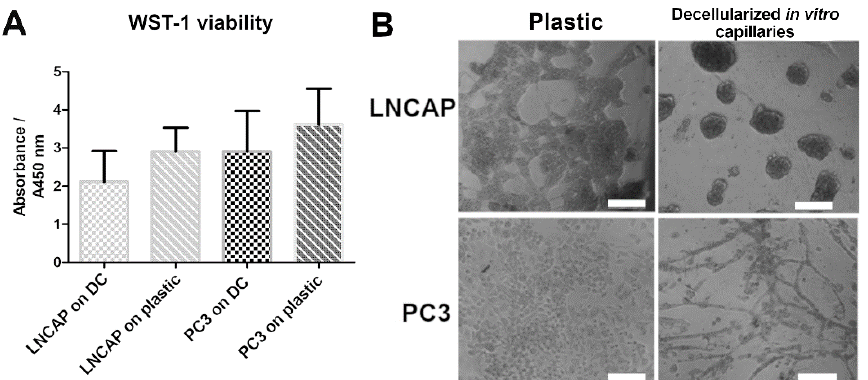
Figure 2. Cell lines grown on decellularized in vitro capillaries (DC). ( A ) WST-1 analysis of the proliferation of LNCAP and PC3 on DC and on plastic. No significant differences were seen between growth surfaces; however, the trend is that DC slows down the proliferation of the cancer cells. ( B ) Exemplary phase-contrast images of the cell lines LNCAP and PC3 grown on DC and on plastic. Both cell lines spread across the plastic surface. On DC, the LNCAP cells form round clusters, and PC3 cells align with the network of capillaries and they can be seen in phase contrast as a network. Scale bar 100 µm. Imaged with Nikon Eclipse Ti-s inverted fluorescence microscope. Table 5. Proliferation and pattern formation of the tested cell lines on decellularized in vitro capillaries (DC). Metastatic cell lines are presented on grey background and non-metastatic cell lines on white background. n = 3. N/A = data not available.